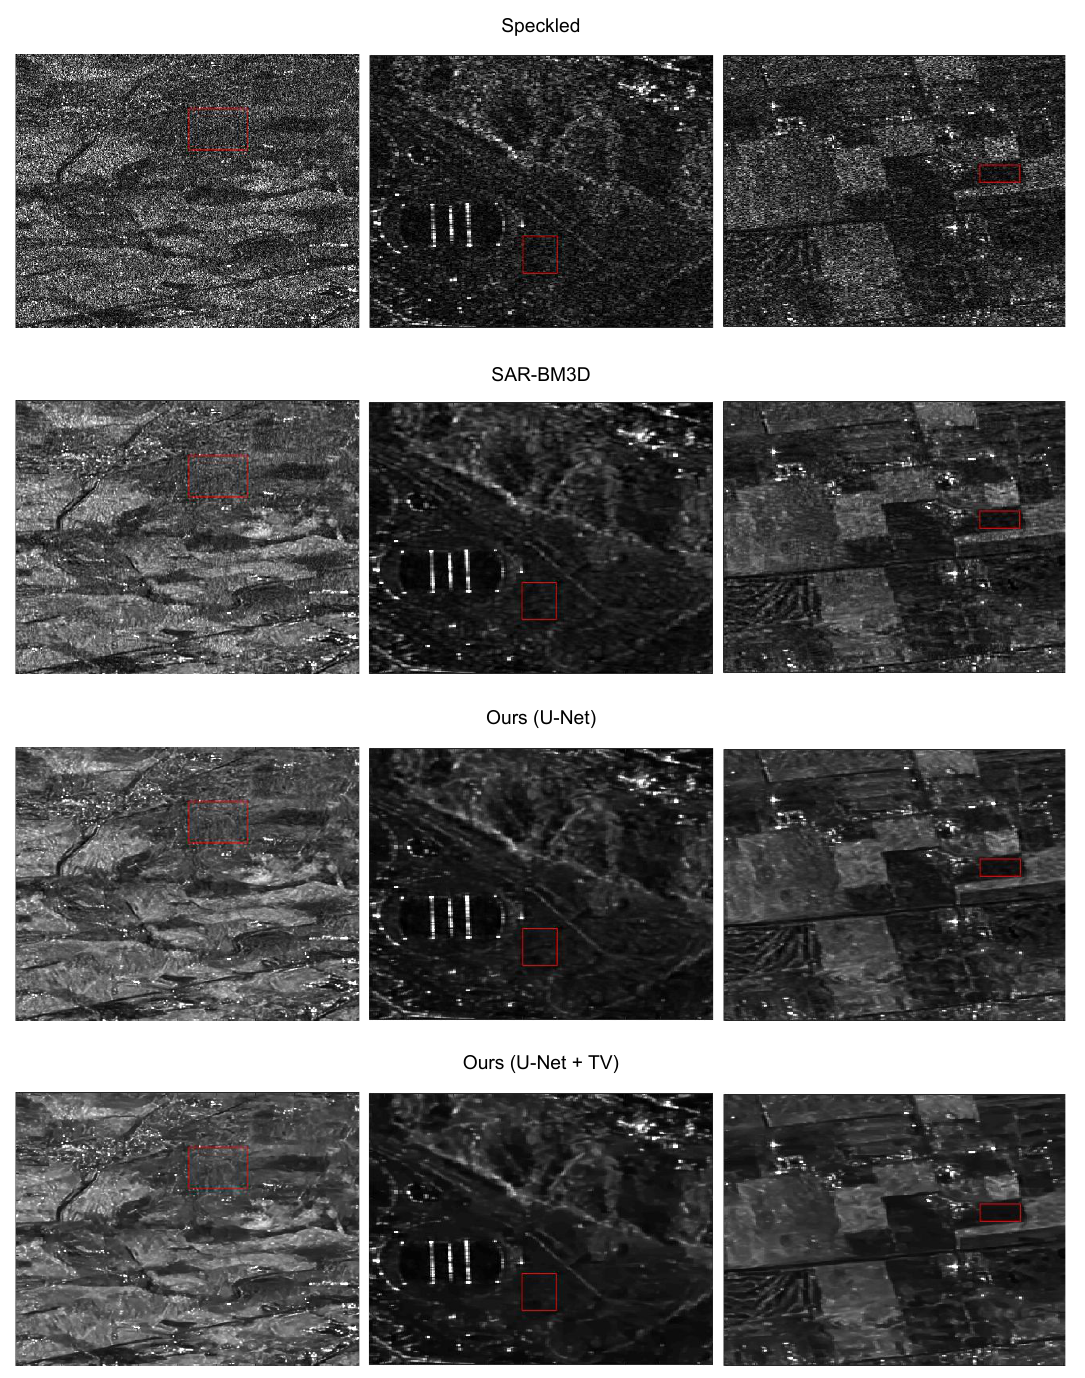
Figure 8. Qualitative results on Sentinel-1 (1-st column), COSMO-SkyMed (2-nd column), and RADARSAT (3-th column) single look images from the test set. The red boxes point out the homogeneous regions selected for the computation of the ENL metric. As can be observed, the reconstructions provided by the proposed method are sharper and less affected by residual